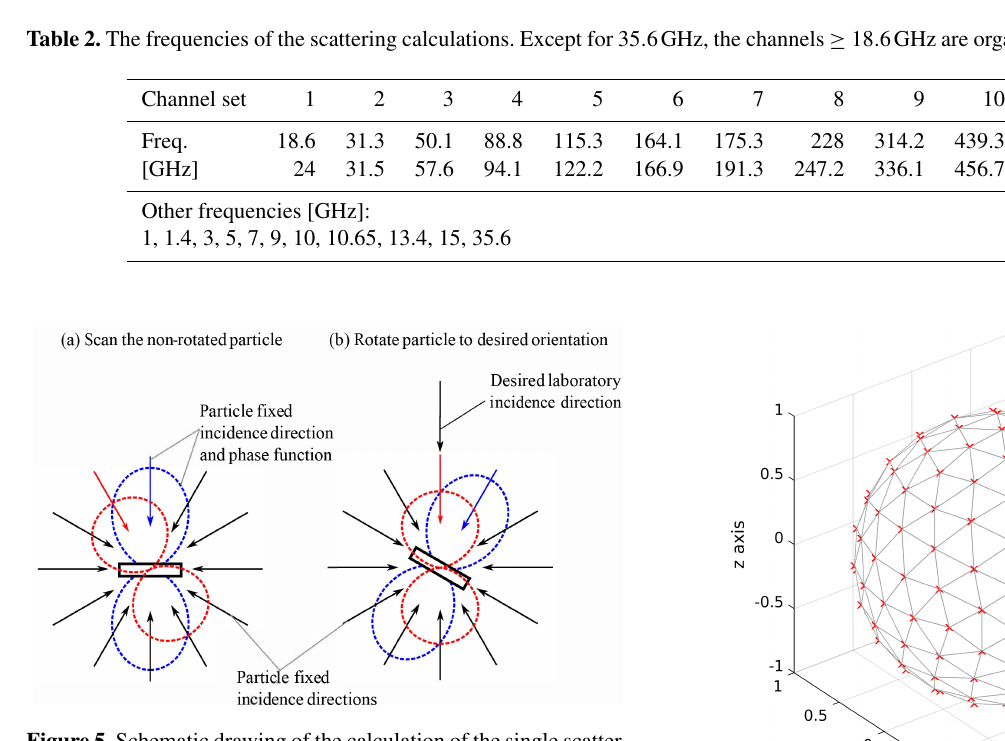
Figure 5. Schematic drawing of the calculation of the single scatter- ing properties. (a) The non-rotated particle with the incidence and scattering directions fixed to the particle. (b) The rotated particle and the rotated incidence and scattering directions.